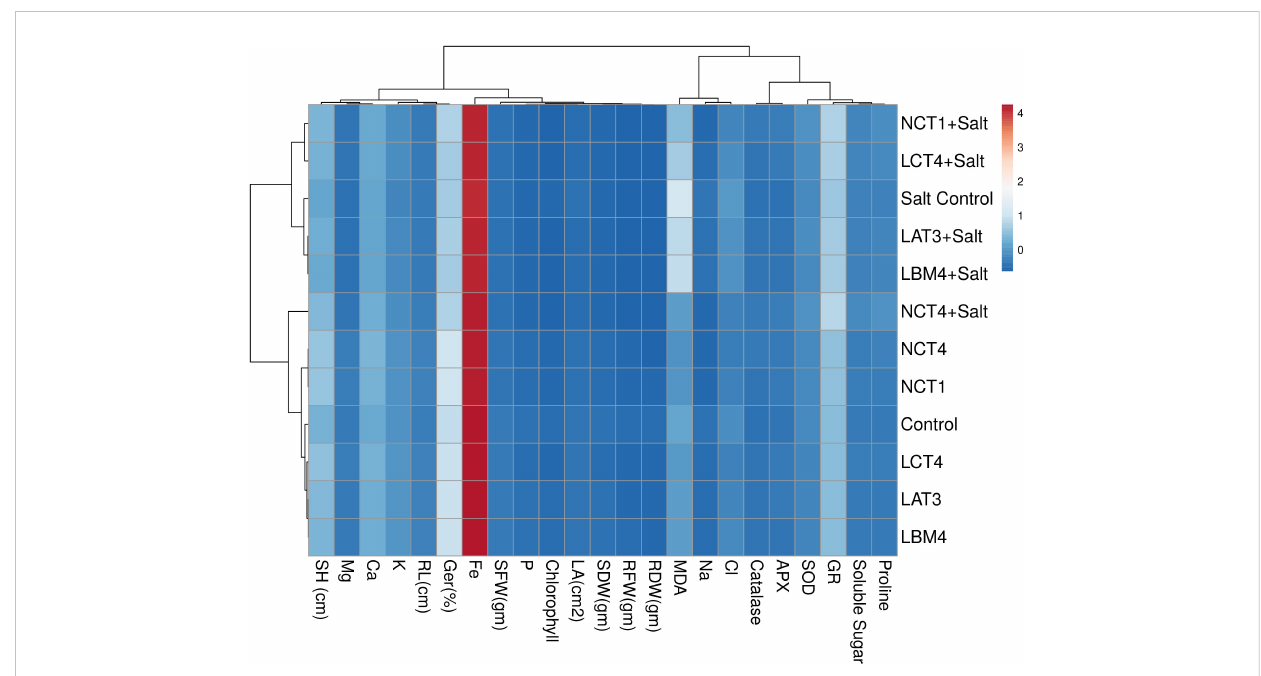
FIGURE 7 Heatmap represents grouping of control and treated plants in PCA on the basis of growth and physico-chemical